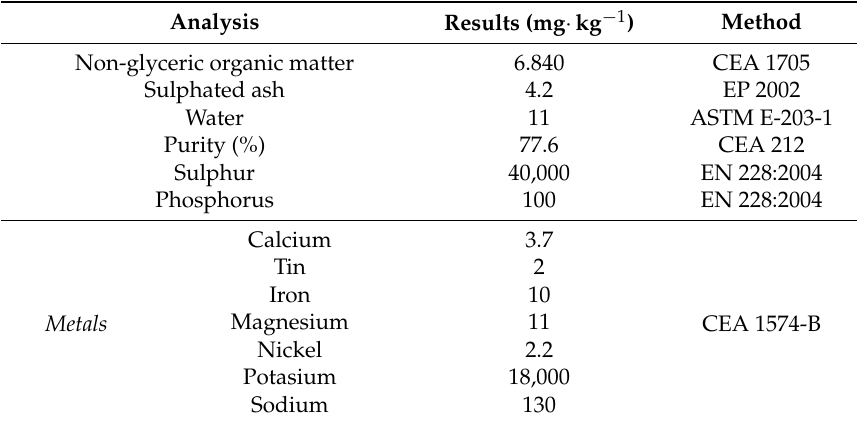
Table 1. Characterization of the